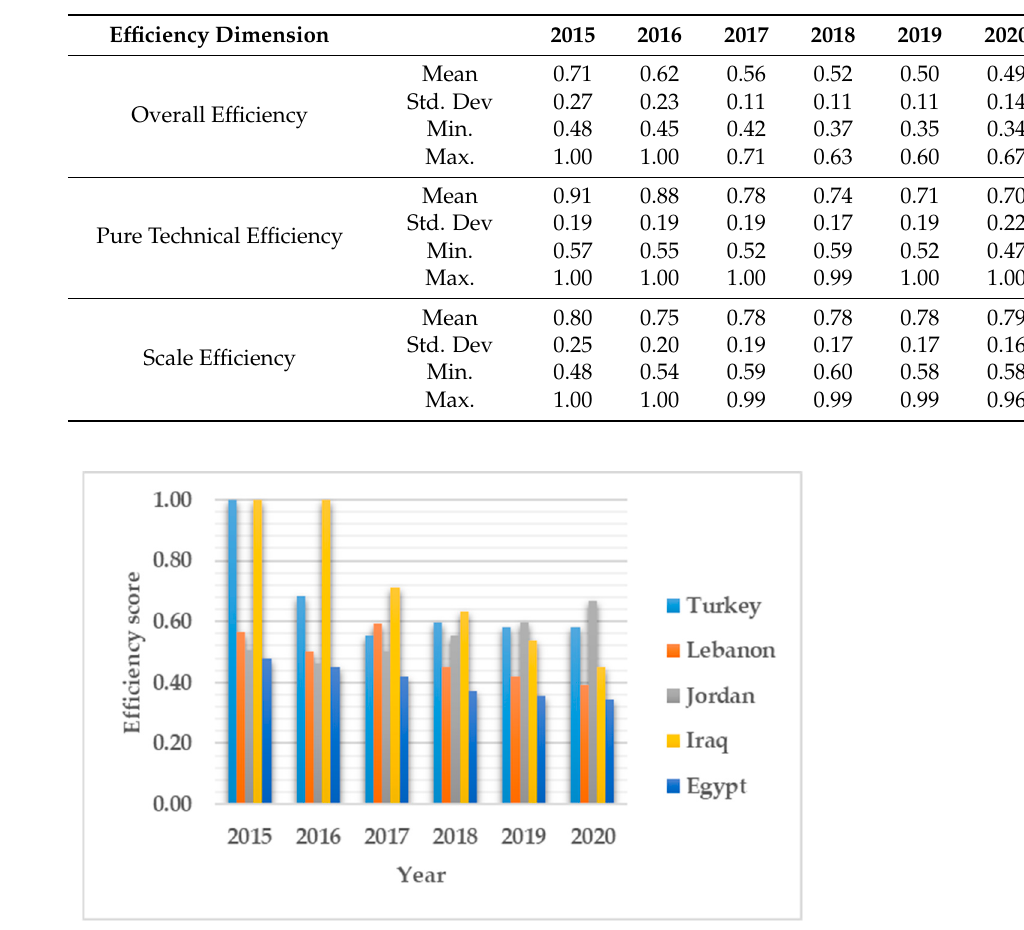
Figure 3. Pure technical efficiency scores.